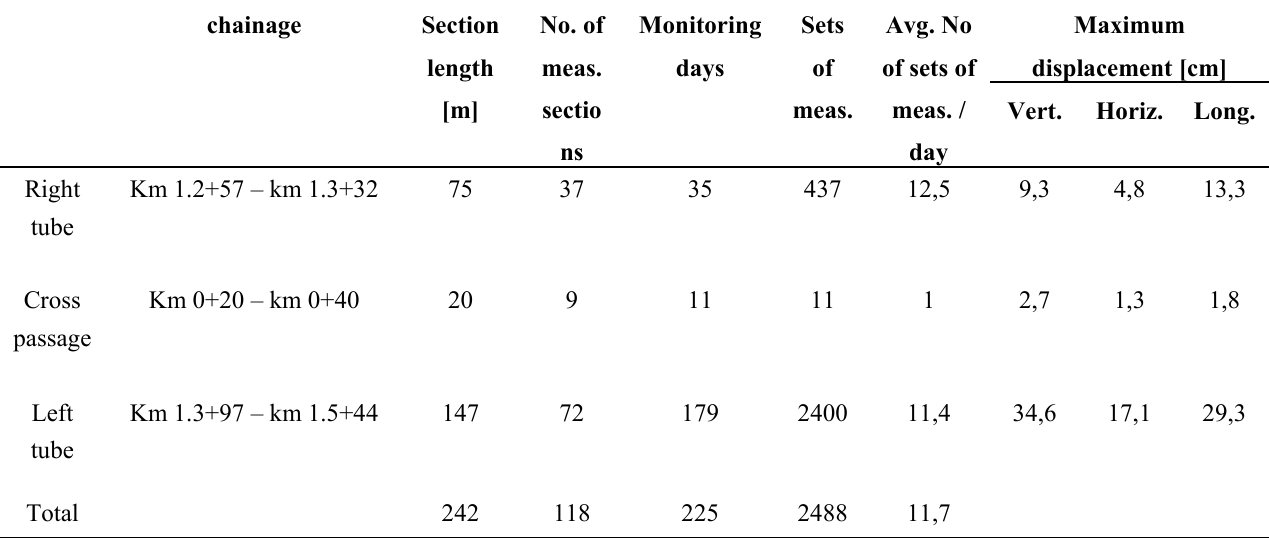
Table 1. Summary of performed 3D displacement measurements in the exploratory tunnel chainage